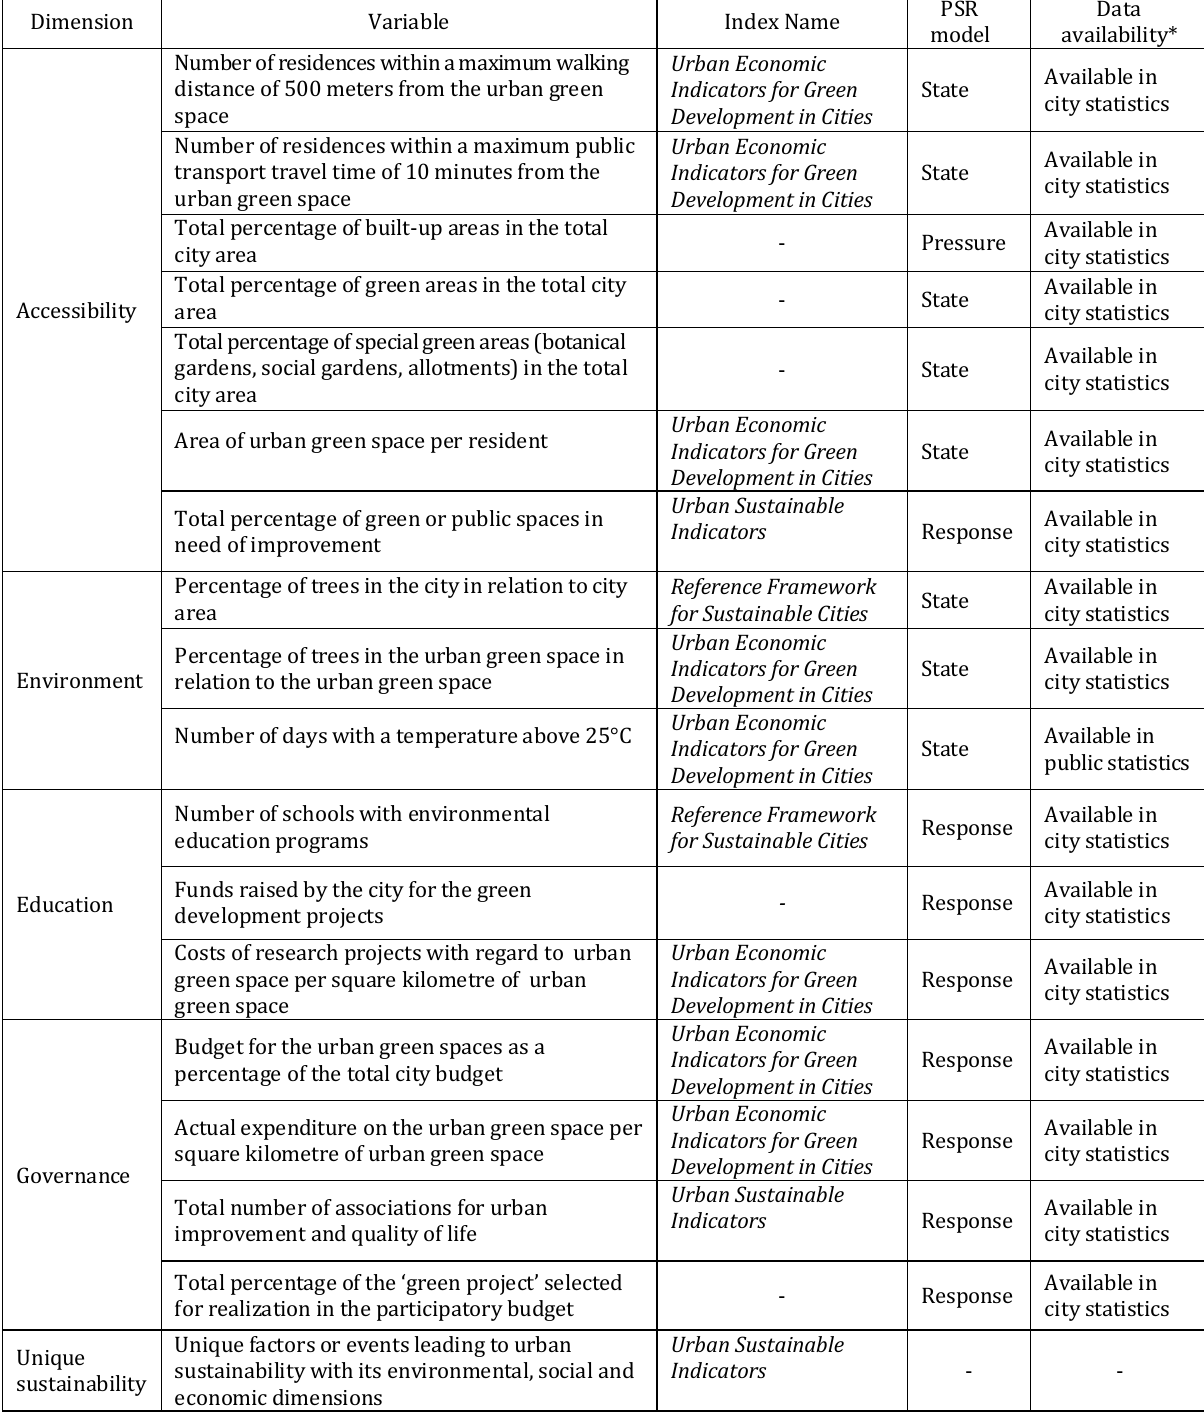
Table 4. Green Development (Source: own